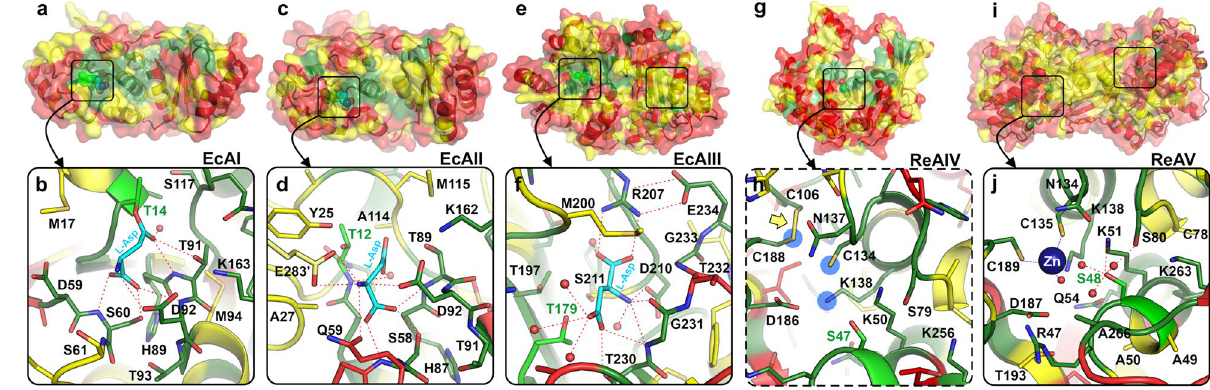
Figure 4. Conservation of residues and the active sites of representative l-asparaginases. Residues are colored according to their conservation: red (highly variable: 0–30% identity), green (highly conserved, 80–100% identity), or yellow (30–80% identity). ( a , b) The EcAI subunit A (a) and a covalent reaction intermediate (b) with a substrate molecule (cyan) in the active site (PDB ID: 2him). ( c,d) The EcAII subunit A with the l-Asp product (cyan) bound in the active site (PDB ID: 3eca). ( e,f) The EcAIII ( ɑ + β) 2 homodimer with the l-Asp product (cyan) bound in the active site (PDB ID: 2zal). ( g,h) A protomer of ReAIV predicted by the Robetta server with a detailed view (h) of the residues in the putative active site; residues potentially involved in Zn 2+ coordination are marked by blue circles; the predicted S–S bridge between Cys188 (putative metal coordination ligand) and Cys106 that might be formed in the absence of a metal cation is marked by a yellow arrow. ( i,j) The ReAV homodimer (i) and the active site (j) with the Zn 2+ ion (dark blue sphere) coordinated close to the nucleophilic Ser48 (PDB ID: 7os5). In all panels, the nucleophilic residue (Thr or Ser) is conserved and colored light